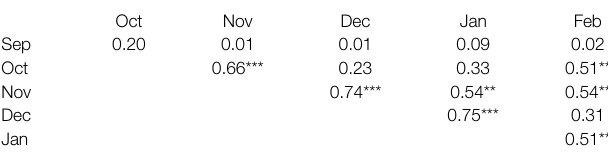
TABLE 2 | As in Table 1 , but for 1979 – 1998.